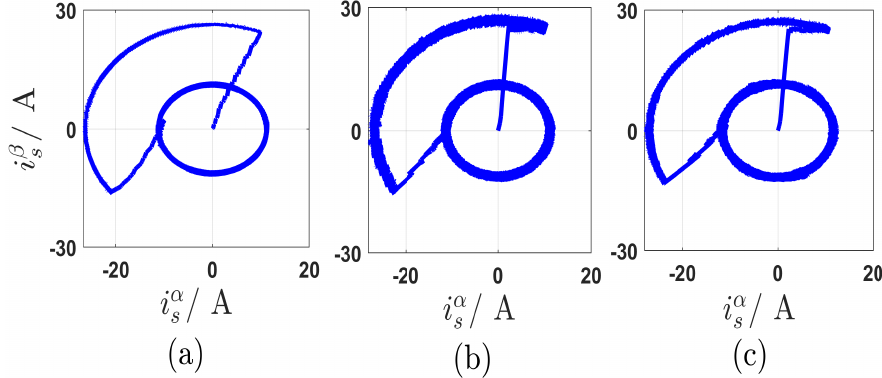
Figure 10. Current trajectory in αβ frame under rotor mechanical speed 500 [rpm]: ( a ) FOC, ( b ) CPC, and ( c ) Proposed